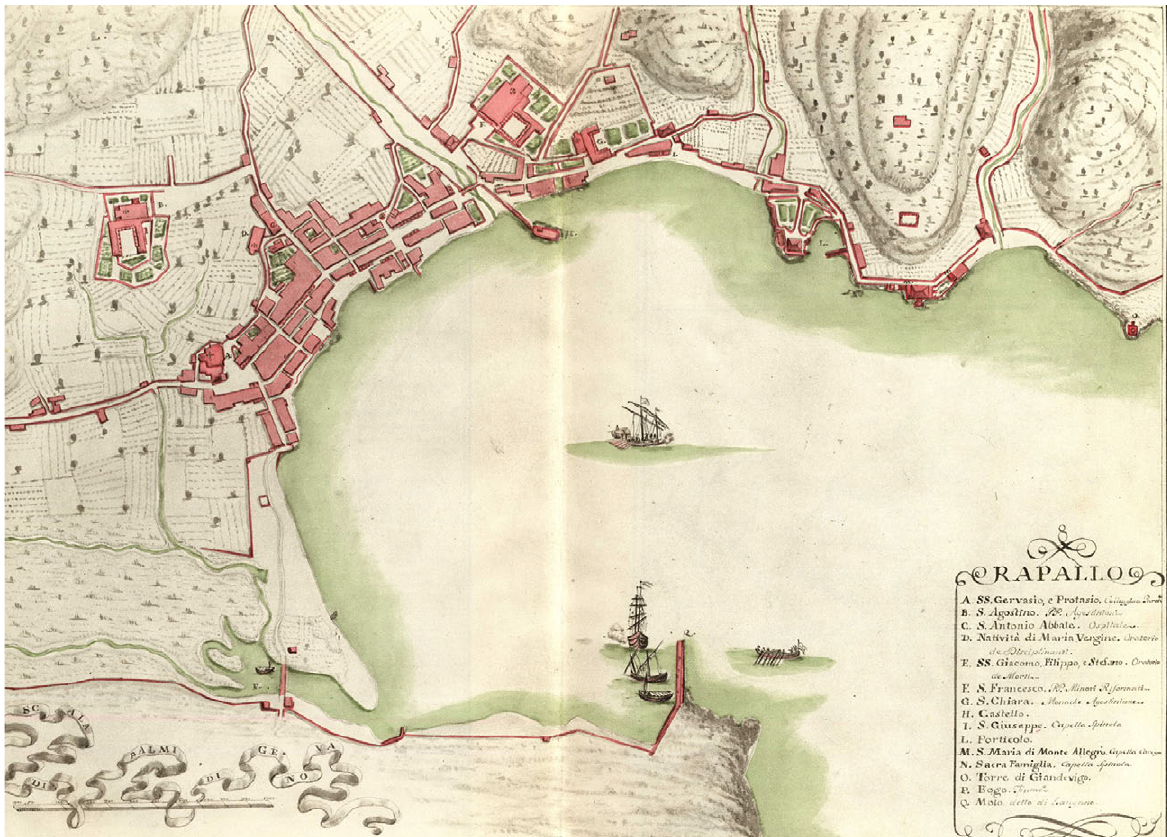
Fig. 5. Rapallo in the late eighteenth century (after Matteo Vinzoni map, 1774).